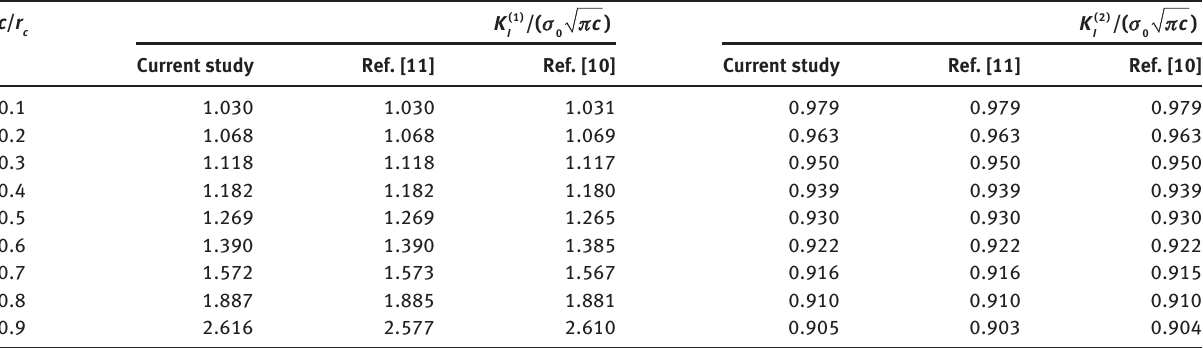
for the case of a concentric annular c